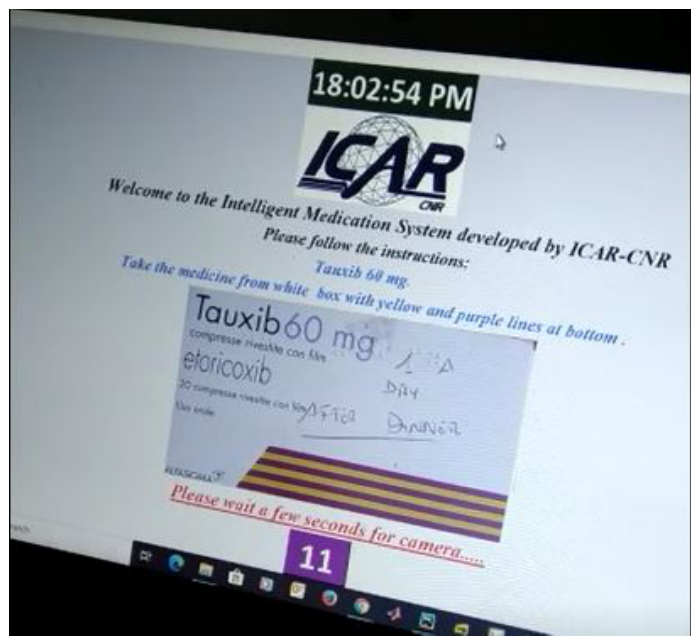
Figure 5. GUI demonstration-1.